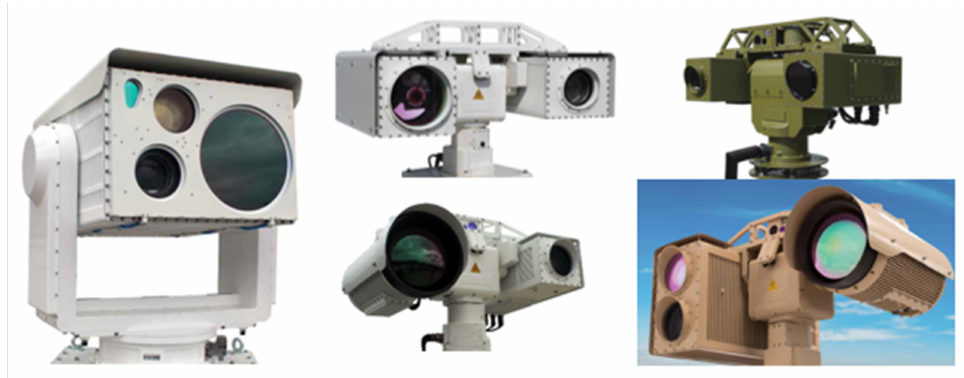
Figure 1. Some family members of VMSIS3 EO